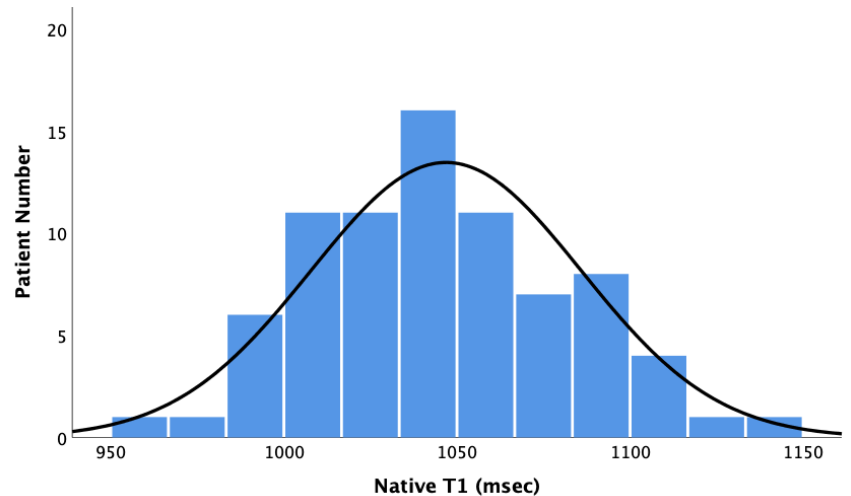
Figure 1. Bar Chart showing the distribution of native T1 values. Baseline native T1 values did not correlate with ∆ LVEF (Pearson r = − 0.002, p = 0.98), ∆ LVEDD (Pearson r = 0.02, p = 0.84), and ∆ LVESD (Pearson r = − 0.05, p = 0.71). However, baseline native T1 values correlated with ∆ LVEDV (Pearson r = 0.291, p = 0.009) and ∆ LVESV (Pearson r = 0.292, p = 0.015) (see Figures 2 and